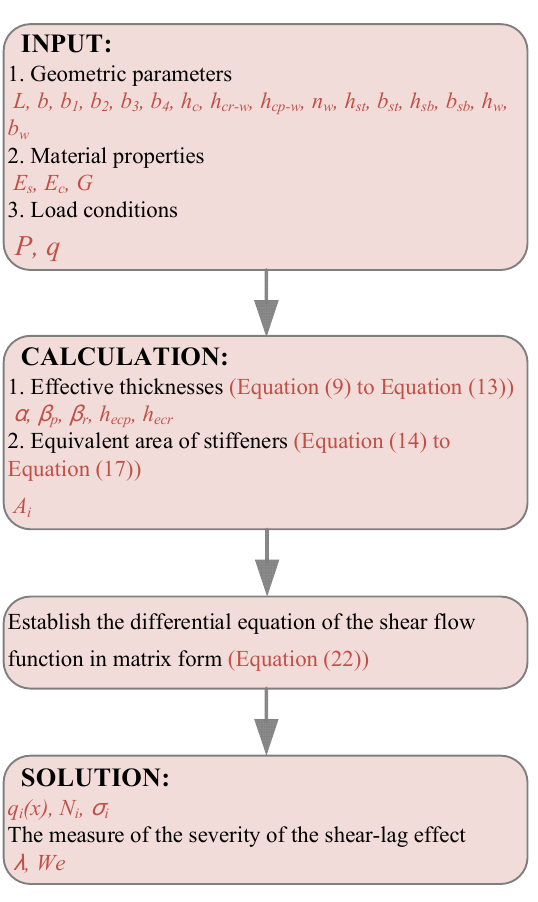
Figure 7. Program calculation flow of the theoretical model.